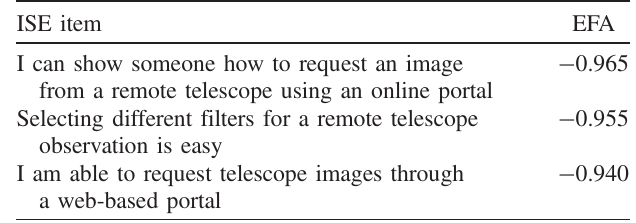
TABLE III. The three highest loading questions contributing to factor